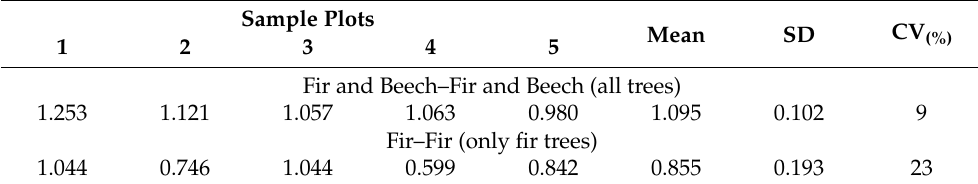
Table 2. The index of aggregation of Clark and Evans.